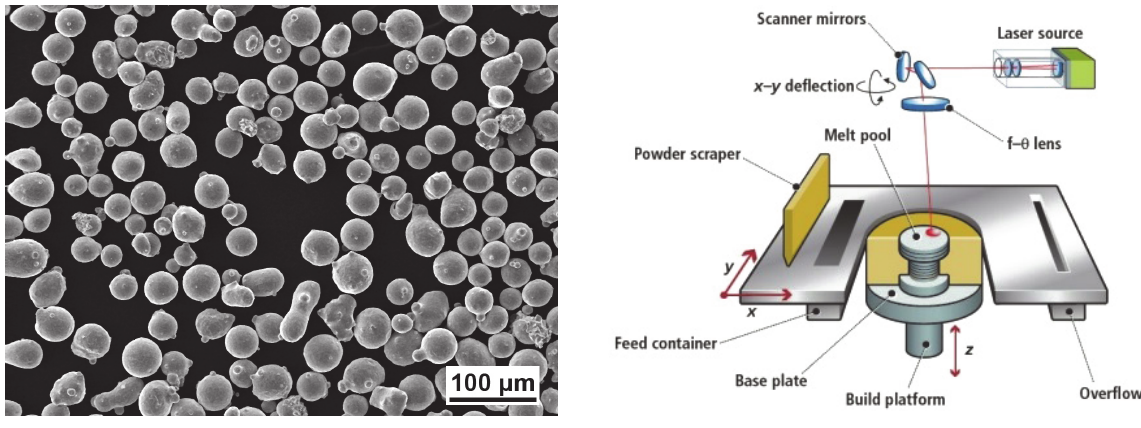
Figure 1: The range of powder sizes, SEM. Figure 2: Scheme of a SLM machine [11].